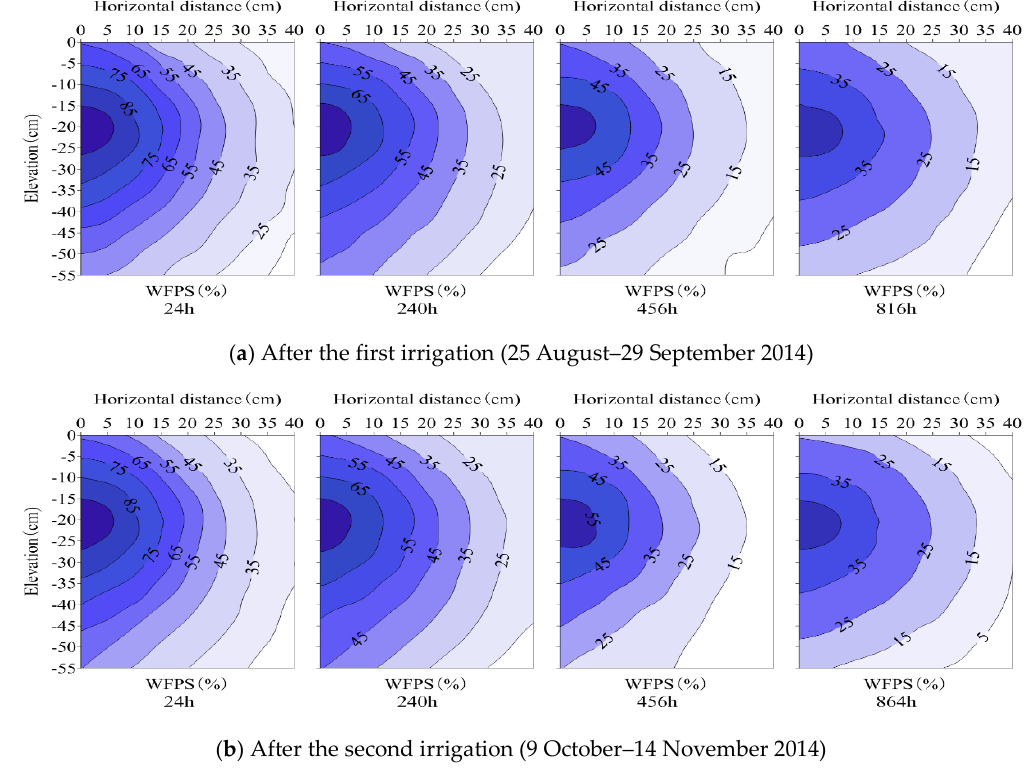
Figure 3. Soil moisture distribution in SDI – 1 treatment (surface soil wetting proportion is 39.7%).